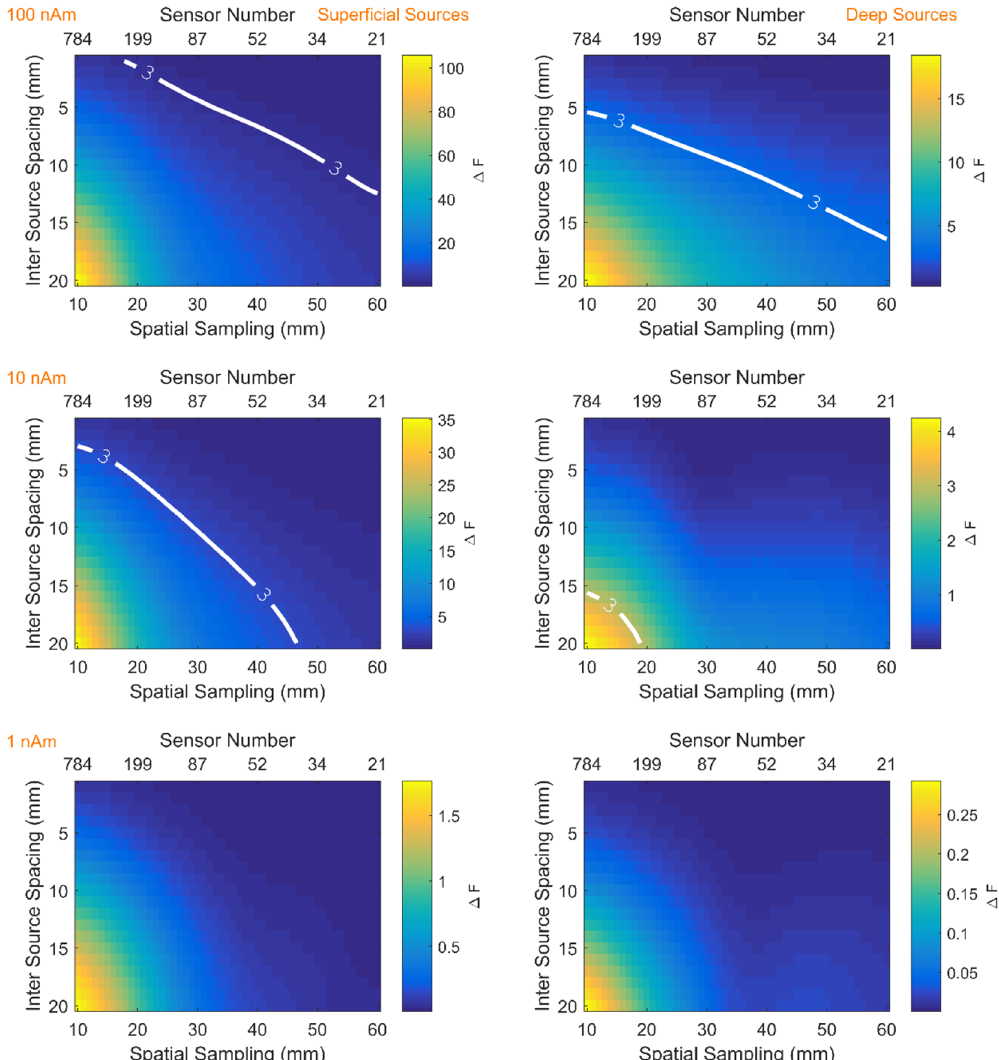
Figure 4. Discrimination between models as a function of spatial sampling density (or channel number). Left and right columns depict shallow and deep sources respectively. Rows show three different source amplitudes (100nAm, 10nAm, 1nAm). The colour scale shows the change in free energy relative to the base model. Thick white lines delineate the sensor spatial sampling necessary to confidently (p < 0.05 or F > 3) discriminate sources at a given inter source spacing. The respective sensor level SNRs for these figures are 28 dB, 8 dB and − 12 dB for superficial sources and 16 dB, − 4 dB and − 24 dB for deep sources. The sensors used in this simulation for point magnetometers displaced 6.5 mm from the